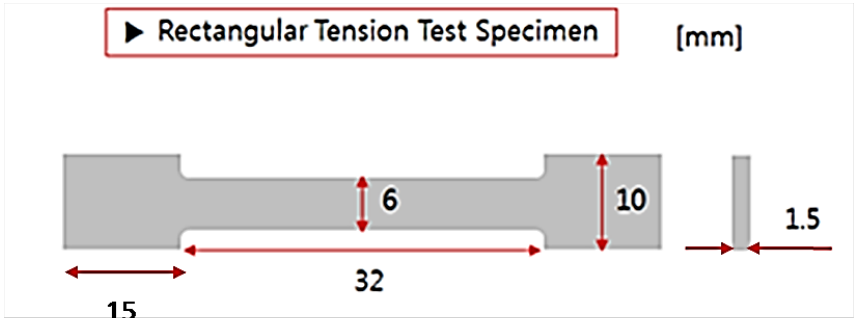
Figure 6. Details of ASTM E8 tensile test